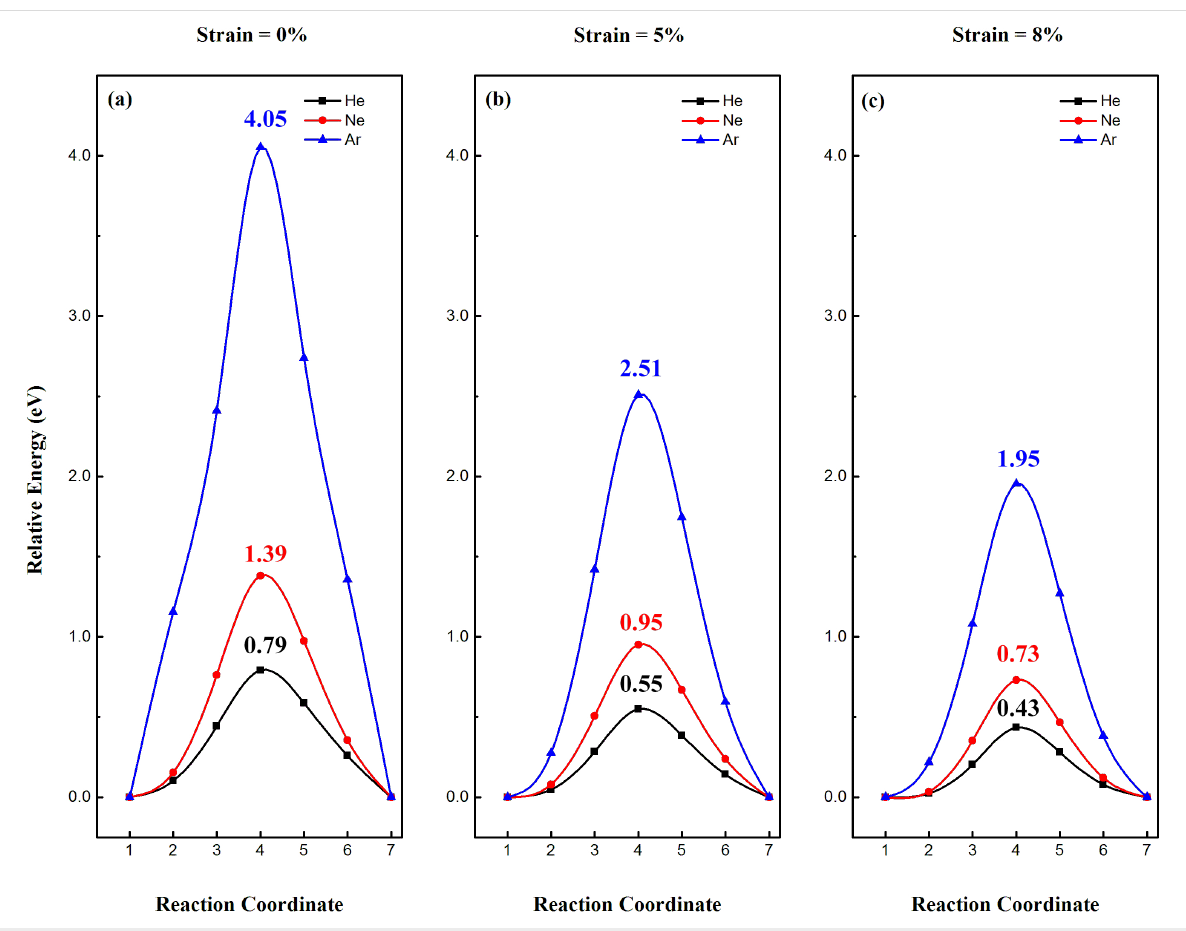
Figure 3: Minimum pathway for noble gases (He, Ne and Ar) passing through a 2D SnH lattice under (a) 0%, (b) 5% and (c) 8% strain.